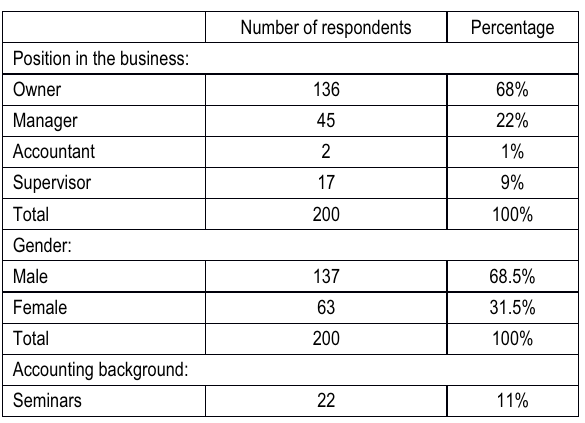
Table 1. Respondents’ personal and their business